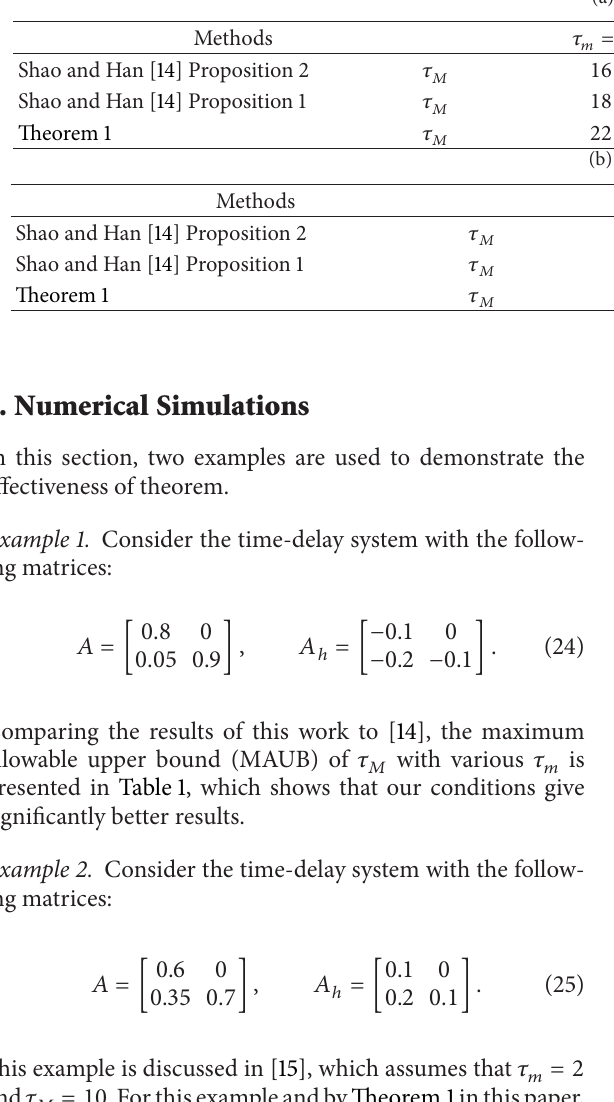
Table 1: Maximum allowable upper bound 𝜏 𝑀 for various 𝜏 𝑚